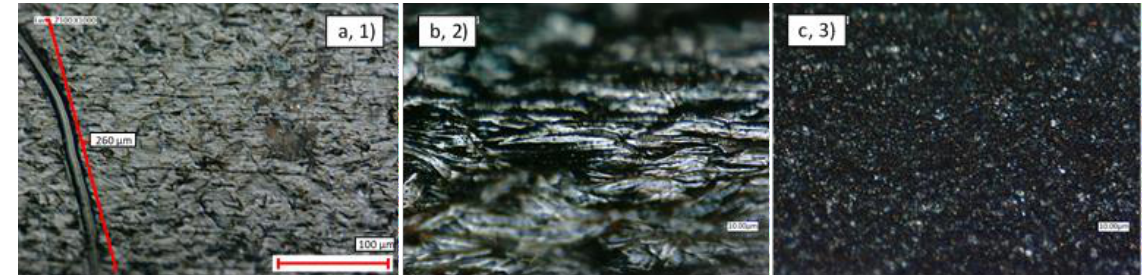
Figure 6. Optical microscopy ×1000 magnification view of the internal surface of: ( a ) Cu Ni thin-walled pipe (1); ( b ) SS thick-walled pipe (2); ( c ) Ti Ni thin-walled pipe (3).